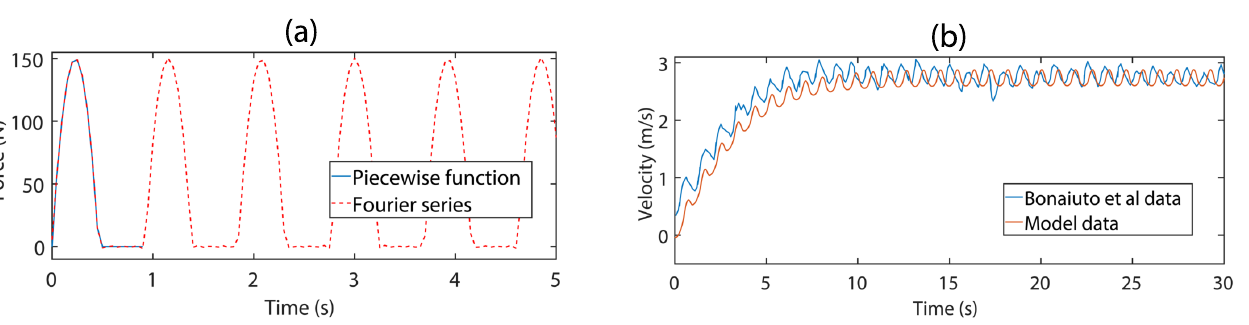
Figure 11. ( a ) Stroke model used, piecewise function versus Fourier series approximation, and ( b ) Bonaiuto et al. [12] experimental data versus model data; horizontal axis is time in seconds. See text for